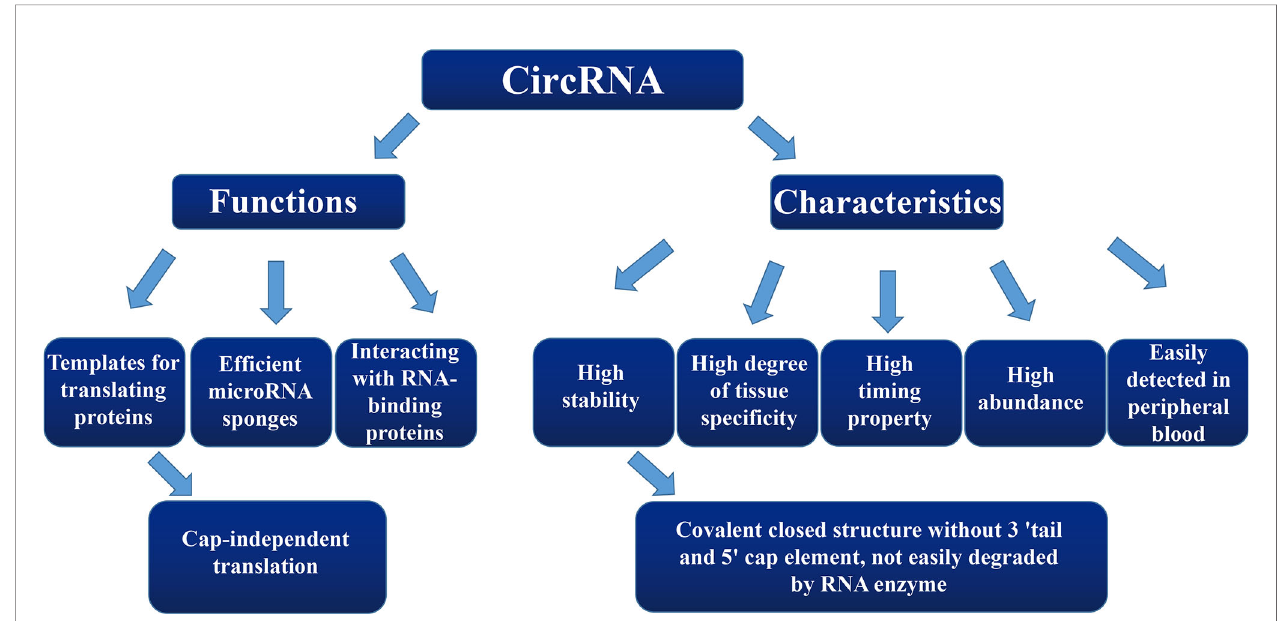
FIGURE 2 | The overview diagram shows multiple biological functions of circular